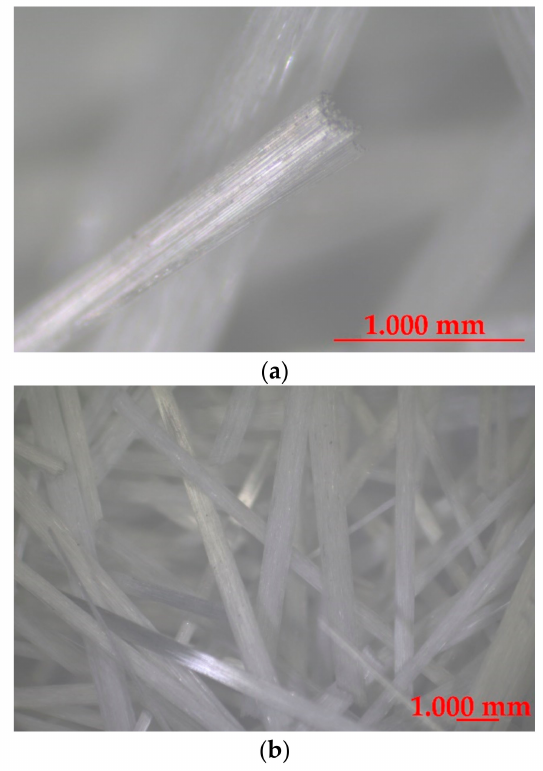
Figure 2. Glass recycled fibers: ( a ) one fiber, ( b ) a few fibers.